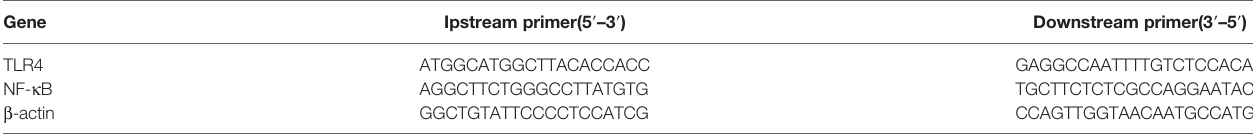
TABLE 1 | PCR primer